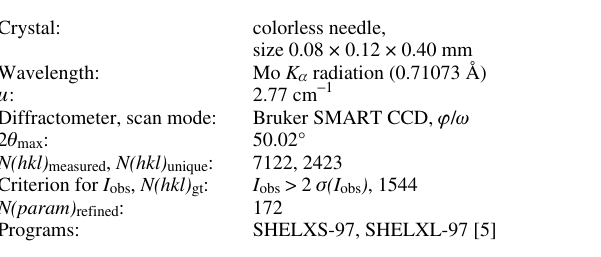
Table 1. Data collection and handling.